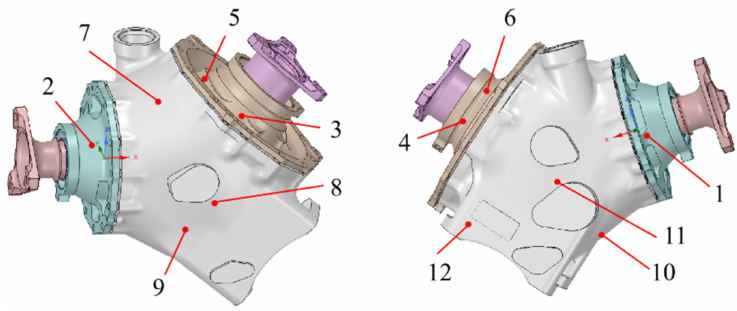
Figure 4. Arrangement of measuring points. 1 and 2—measuring points on the end cover near the input bearing; 3, 4, 5, and 6—measuring points on the end cover near the output bearing; 7, 8, 9, 10, 11, and 12—measuring points on the wall of the casing. Table 4. Experimental temperatures of the measured